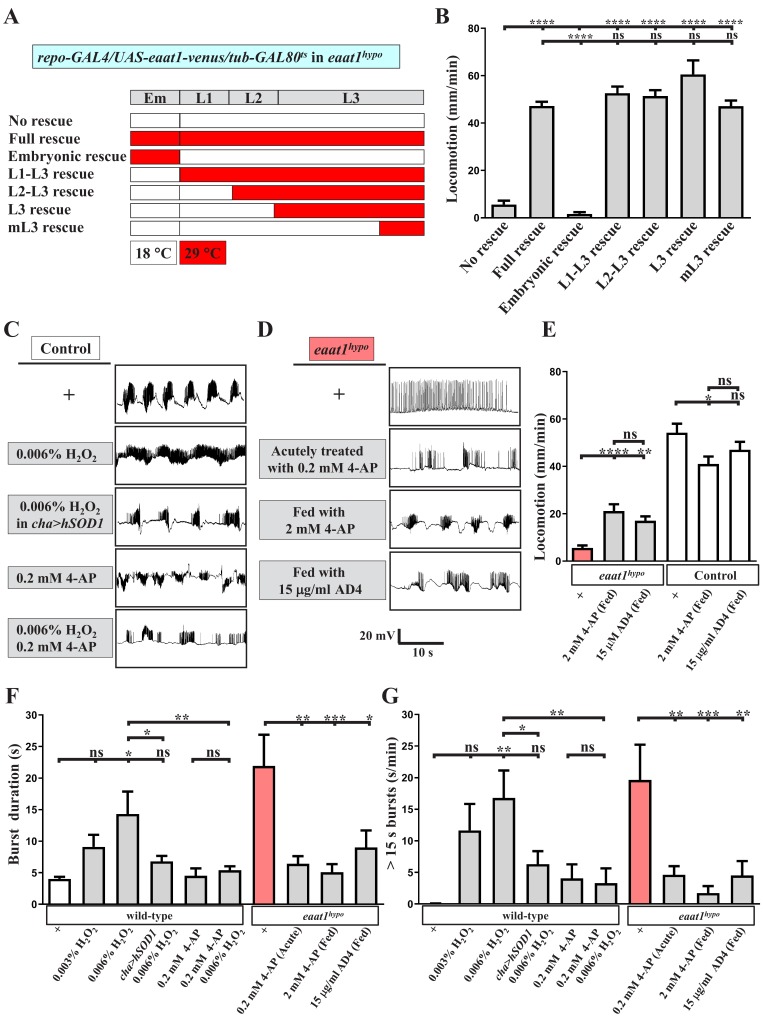
Increased excitotoxicity-induced ROS hampers the excitability of cholinergic interneurons.(A–B) The locomotion defect caused by loss of eaat1 is rescued by expressing eaat1-venus at the late larval stage. (A) Schematic of the temporal expression of UAS-eaat1-venus controlled by the GAL80ts/GAL4 system during embryonic and larval stages. Animal genotypes are indicated. Developmental timescale of larvae at 18°C and 29°C: Em (embryo stage, 0–48 hr after egg laying (18°C) and 0–12 hr after egg laying (29°C)); L1 (first instar larvae, 0–48 hr after embryo hatching (18°C) and 0–12 hr after embryo hatching (29°C)); L2 (second instar larvae, 48–96 hr after embryo hatching (18°C) and 12–24 hr after embryo hatching (29°C)); and L3 (third instar larvae, 96–240 hr after embryo hatching (18°C) and 24–60 hr after embryo hatching (29°C)). Expression of eaat1-venus was restricted at 18°C (white boxes), but was switched on at 29°C (red boxes). (B) Quantification data for locomotion of third instar larvae (n ≥ 8 third instar larvae for each genotype). (C) Acute exposure of H2O2 phenocopies the prolonged burst duration of the motor CPG, which is reversed by expression of hSOD1 in cholinergic interneurons or by 0.2 mM 4-AP treatment. The representative traces show EJPs evoked by spontaneous motor CPG activity during fictive locomotion obtained from third instar wild-type controls (w1118) and third instar wild-type controls expressing hSOD1 with cha-GAL4. Larval fillets were acutely exposed to 0.006% H2O2-containing HL3 solution for 3 min, followed by 10 min recordings in the same solution. For 4-AP treatment, larval fillets were bathed in 0.2 mM 4-AP-containing HL3 solution for 5 min and then bathed in 0.2 mM 4-AP/0.006% H2O2-containing HL3 solution for 3 min, followed by 10 min recordings in the same solution. Quantification data for burst duration and overall firing time (for bursts of >15 s) per recording minute are shown in panels (F,G) (n ≥ 8 animals for each genotype). (D) Prolonged burst duration caused by loss of eaat1 can be rescued by acute treatment of 0.2 mM 4-AP or by long-term feeding of 2 mM 4-AP or 15 μg/ml AD4. Representative EJP traces evoked by spontaneous motor CPG activity during fictive locomotion obtained from third instar eaat1hypo/hypo mutants. Larval fillets were bathed in 0.2 mM 4-AP-containing HL3 solution for 5 min, followed by 10 min recordings in the same solution. For long-term drug treatment, eaat1hypo mutants were fed with 2 mM 4-AP or 15 μg/ml AD4 throughout the larval stage. Larval fillets were subjected to recordings in HL3 solution. Quantification data for burst duration and overall firing time (for bursts of >15 s) per recording minute are shown in panels (F,G) (n ≥ 7 animals for each genotype). (E) Long-term feeding of 2 mM 4-AP or 15 μg/ml AD4 improves locomotion of eaat1hypo mutants. 2 mM 4-AP but not 15 μg/ml AD4 slightly reduced locomotion of control (w1118) larvae. Locomotion of treated larvae was measured and quantified (n ≥ 17 animals for each genotype). P values: ns, no significance; *, p<0.05; **, p<0.01; ***, p<0.001; ****, p<0.0001. n: replicate number. Error bars indicate SEM. Statistics: one-way ANOVA with Tukey’s post hoc test.10.7554/eLife.47372.025Figure 5—source data 1.Source data for Figure 5.